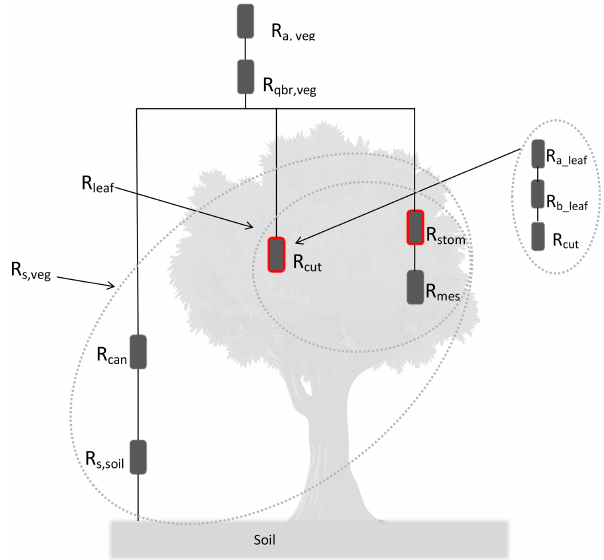
Figure 1. Dry deposition resistance analogy (adapted from Zhang et al., 2003); modified resistors are marked with red